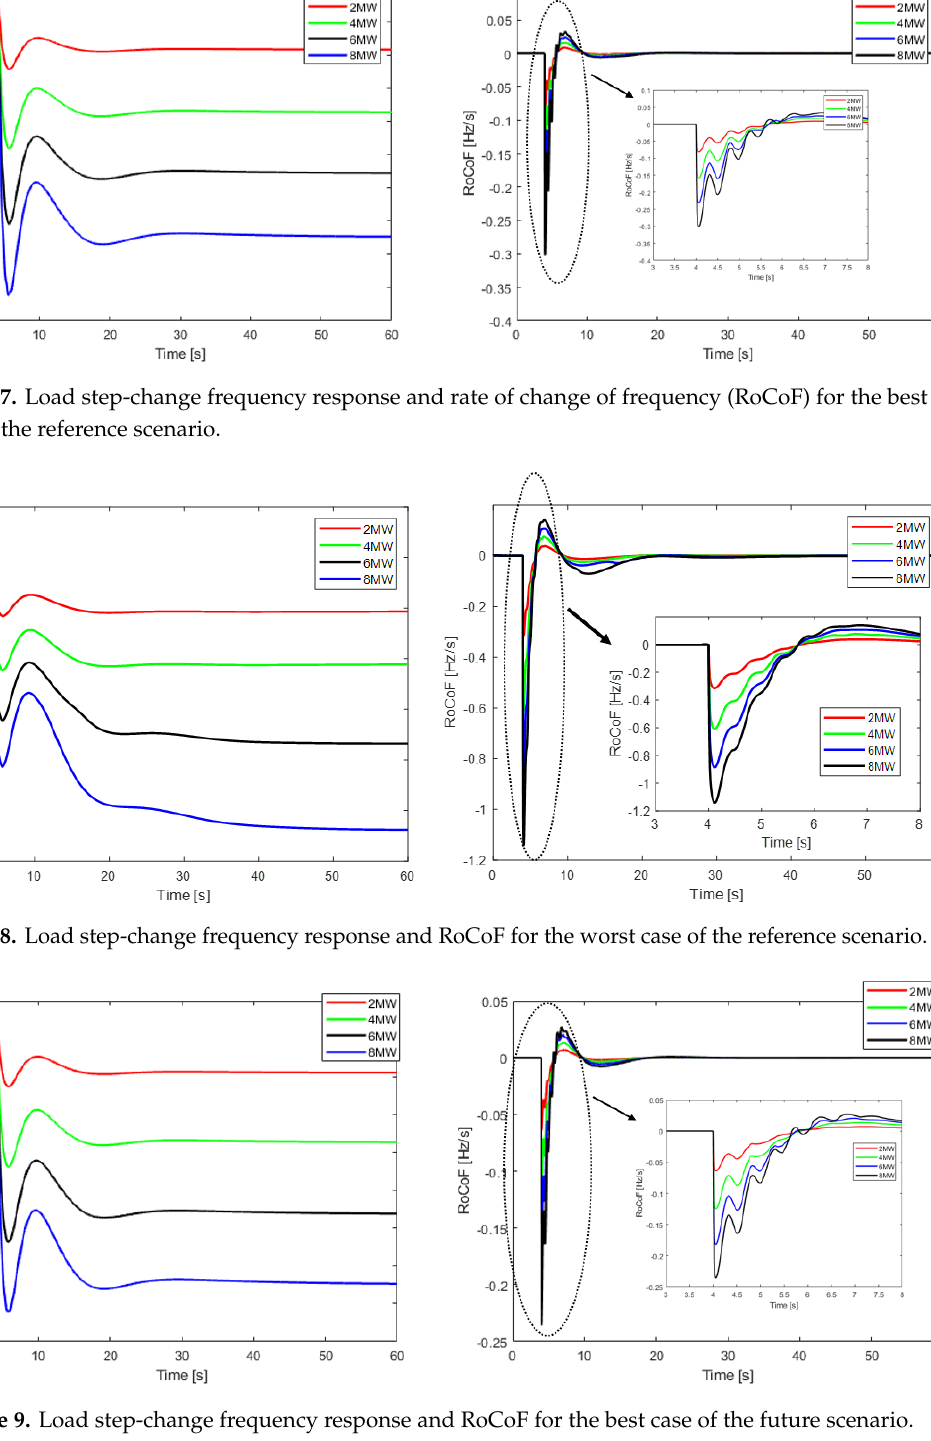
Figure 9. Load step-change frequency response and RoCoF for the best case of the future scenario.